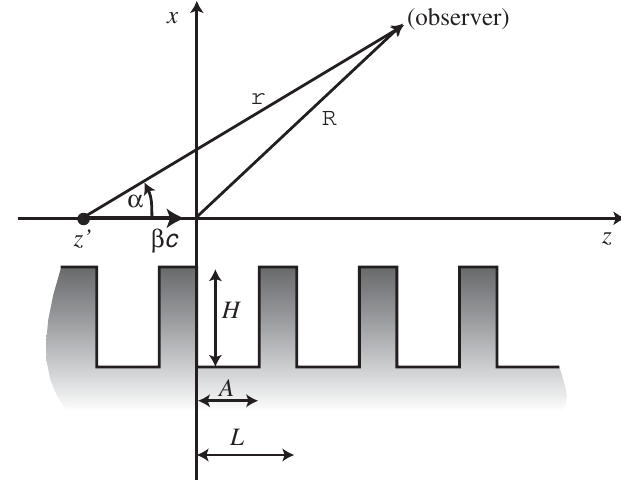
FIG. 7. Graphical representation of wave number relation. FIG. 8. Radiation from an infinitely long